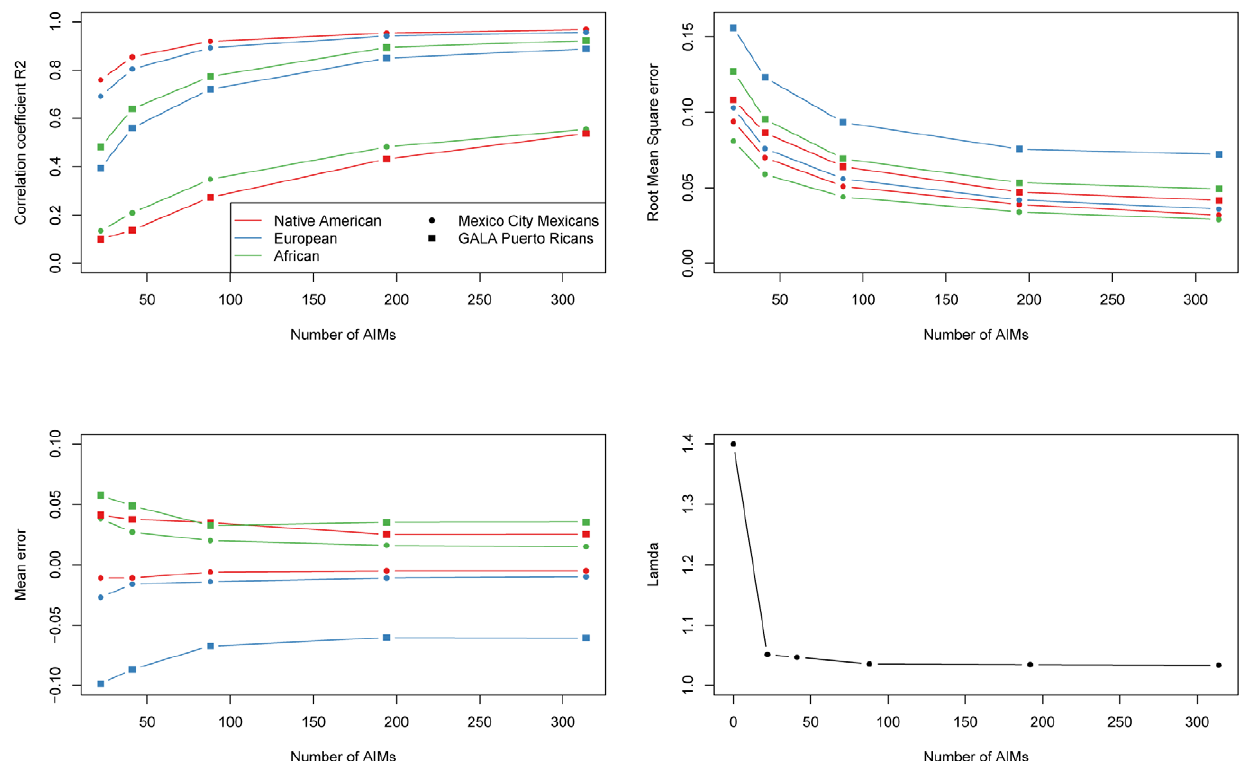
Figure 2. Performance of nested subsets of AIMs.